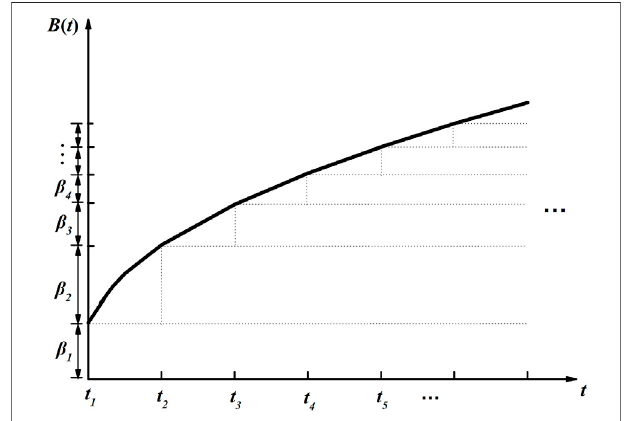
FIGURE 10 | Piecewise Heaviside